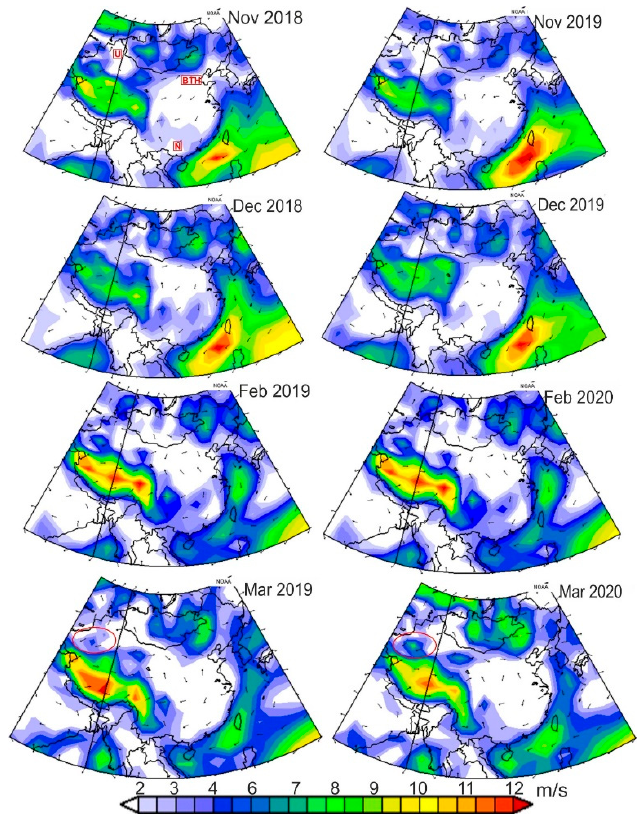
Figure 4. NCEP/NCAR reanalysis composite mean surface wind speed (m/s). Source: NOAA Physical Sciences Laboratory. Locations of Beijing − Tianjin − Hubei (BTH), Nanning (N), and Urumqi (U) are given in top left figure. Red ellipse on March figures highlights change in wind speeds over Taklimakan desert.